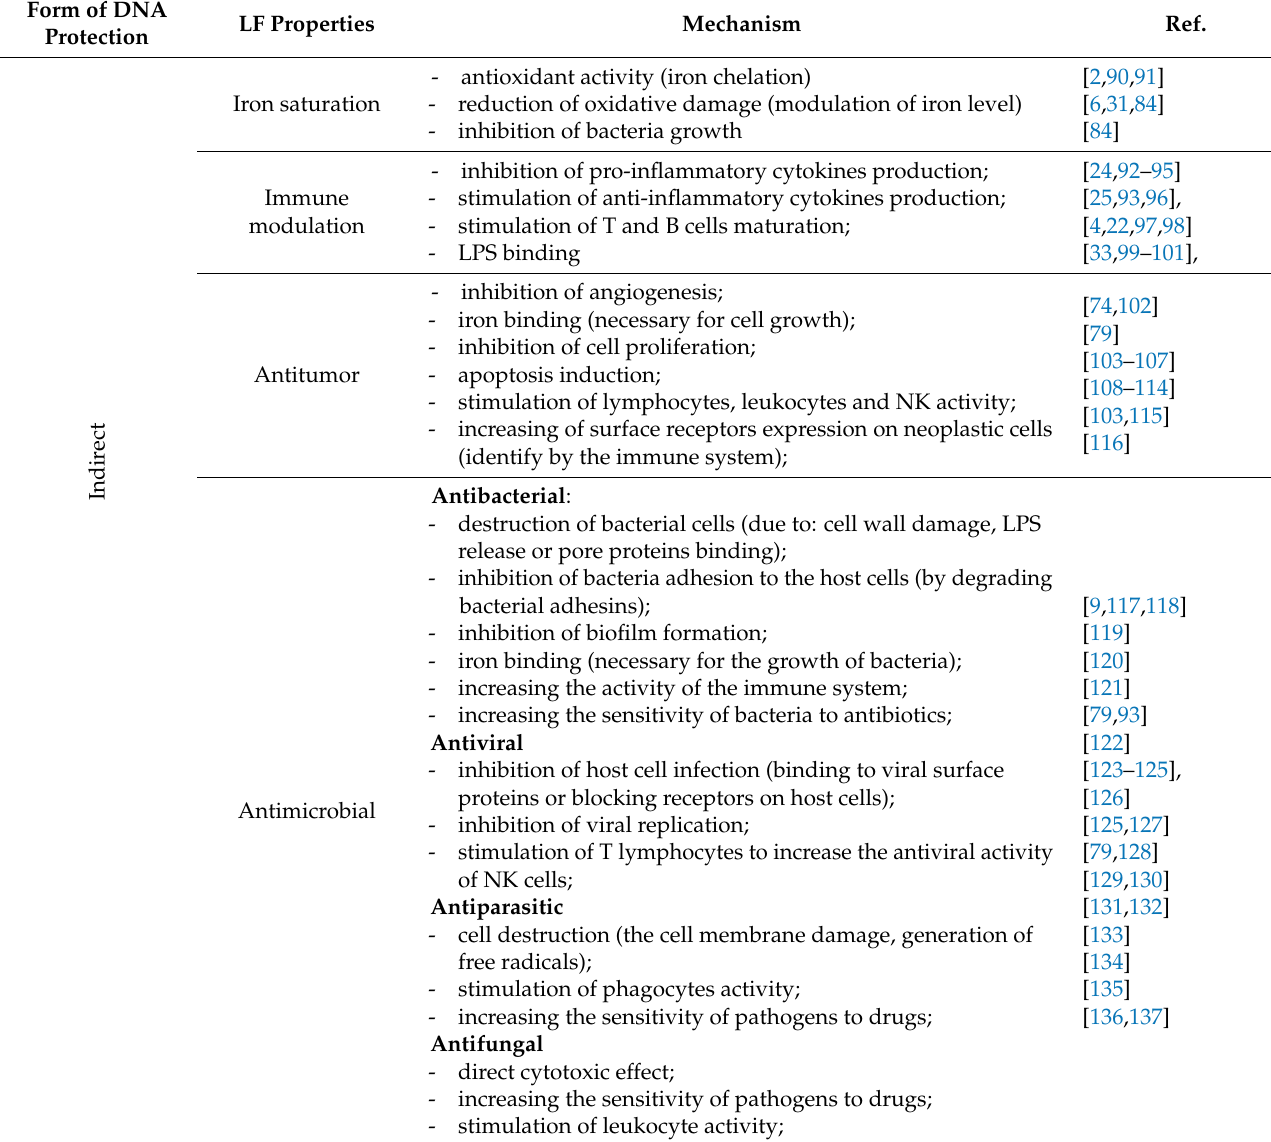
Table 1. Lactoferrin properties and mechanism of action—DNA protection in direct and indirect way. Form of DNA LF Properties Protection